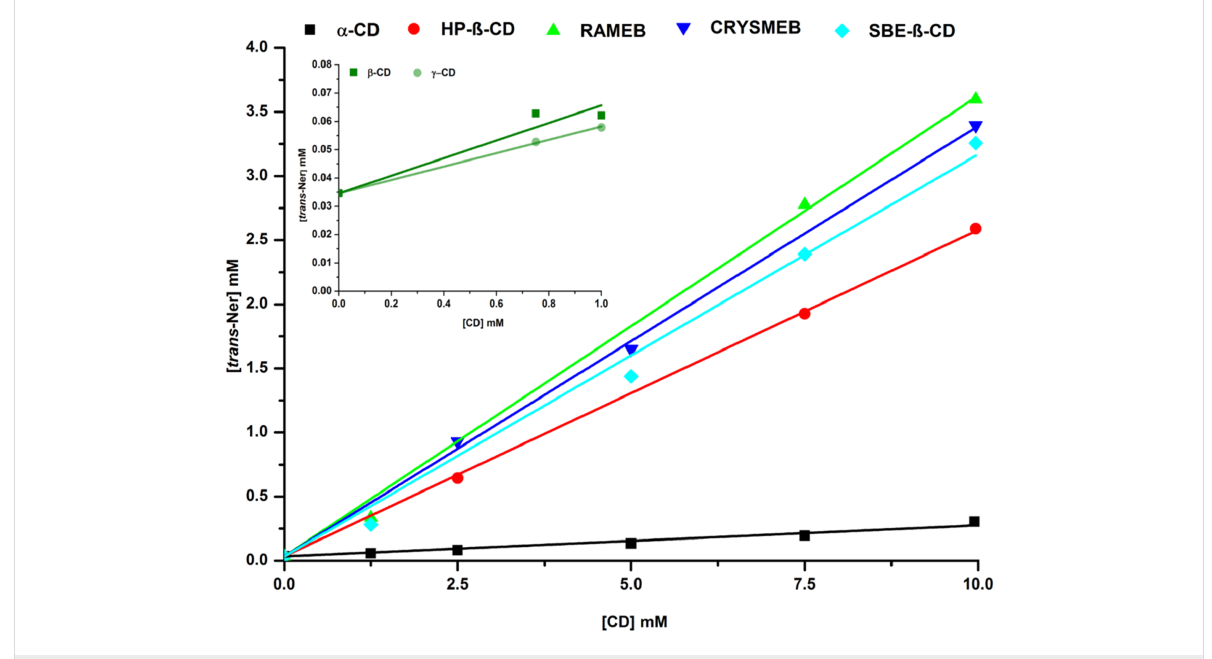
Figure 2: Phase solubility diagrams of CD/ trans -Ner inclusion complexes.